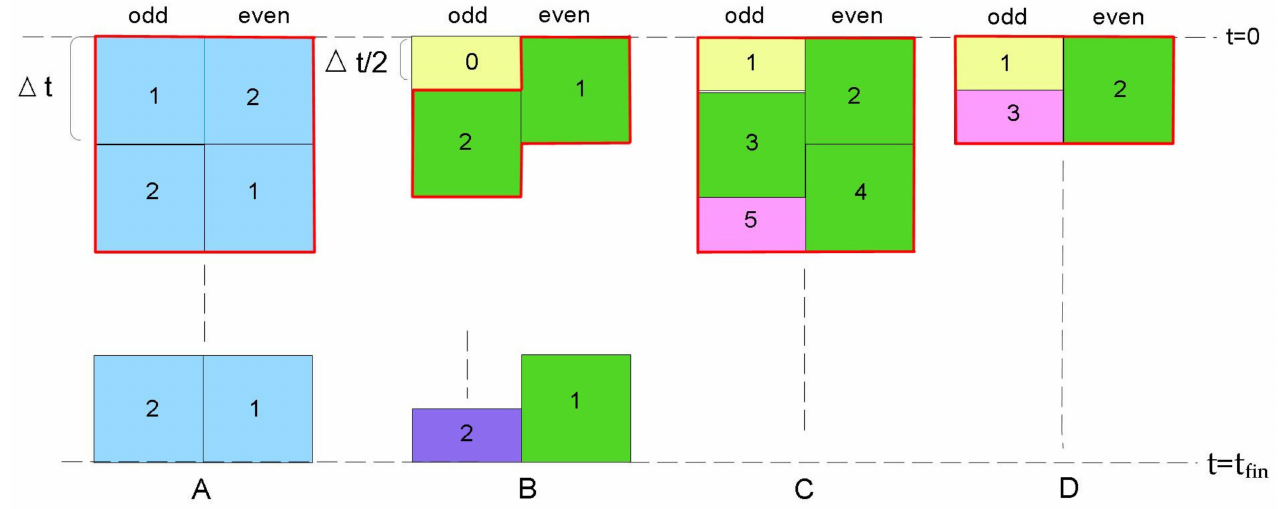
Figure 1. Space–time structure of ( A ) the original hopscotch and the reversed hopscotch meth- ods, ( B ) the shifted-hopscotch method, ( C ) the leapfrog-hopscotch method, ( D ) the asymmetric hopscotch